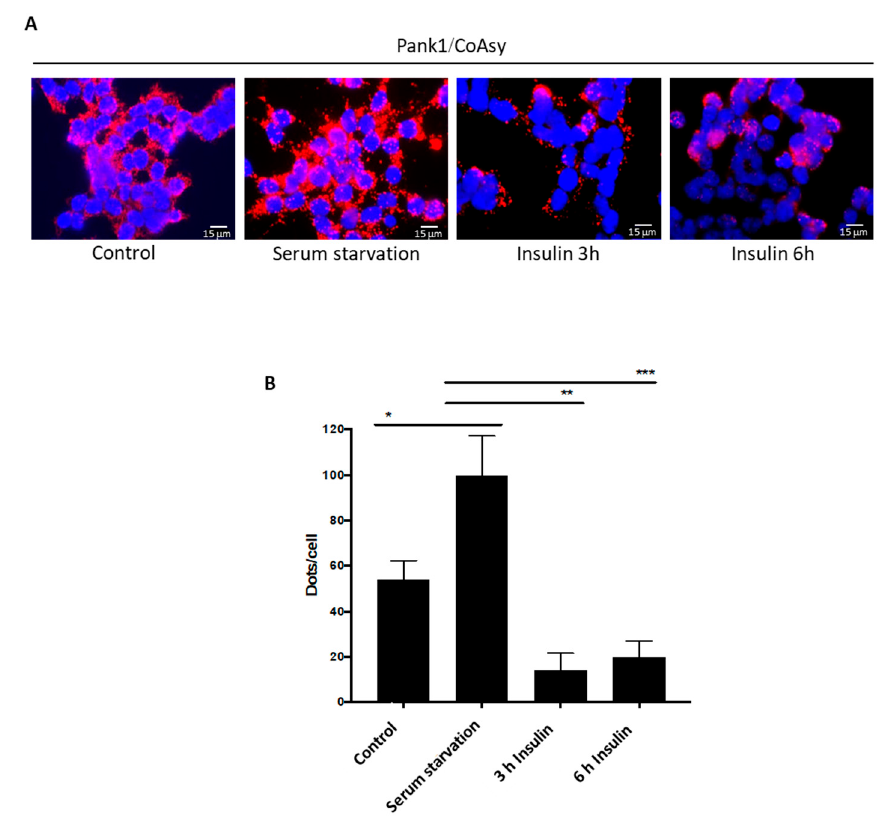
Figure 4. Insulin treatment inhibits the interaction between Pank1 and CoAsy in serum-starved HEK293/Pank1 β cells. ( A ) Pank1 and CoAsy interaction is inhibited in response to insulin treatment in HEK293/Pank1 β cells. Cells were starved for 16 h and treated with 1 µ M insulin for 3 h or 6 h. Control cells were not starved or treated with insulin. Nuclei are stained with DAPI (blue); proximity ligation assay (PLA) was performed for Pank1 and CoAsy (Red). Scale bars: 15 µ m. Data are representative of three independent experiments. ( B ) Relative quantitation of Pank1/CoAsy association in tested conditions from ( A ). Dots/cell counted. Data are presented as mean ± standard error of the mean (SEM) from n = 3 experiments (* p < 0.05; ** p < 0.01; *** p <